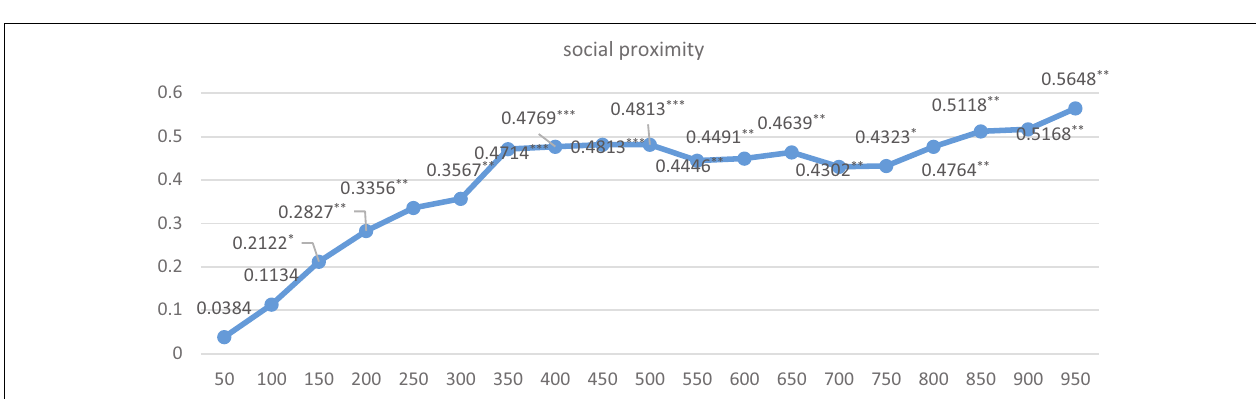
FIGURE 3 | The regression results under social proximity with different kilometers. ***, **, and * indicate that the significance level is at the 1%, 5%, and 10%, respectively.